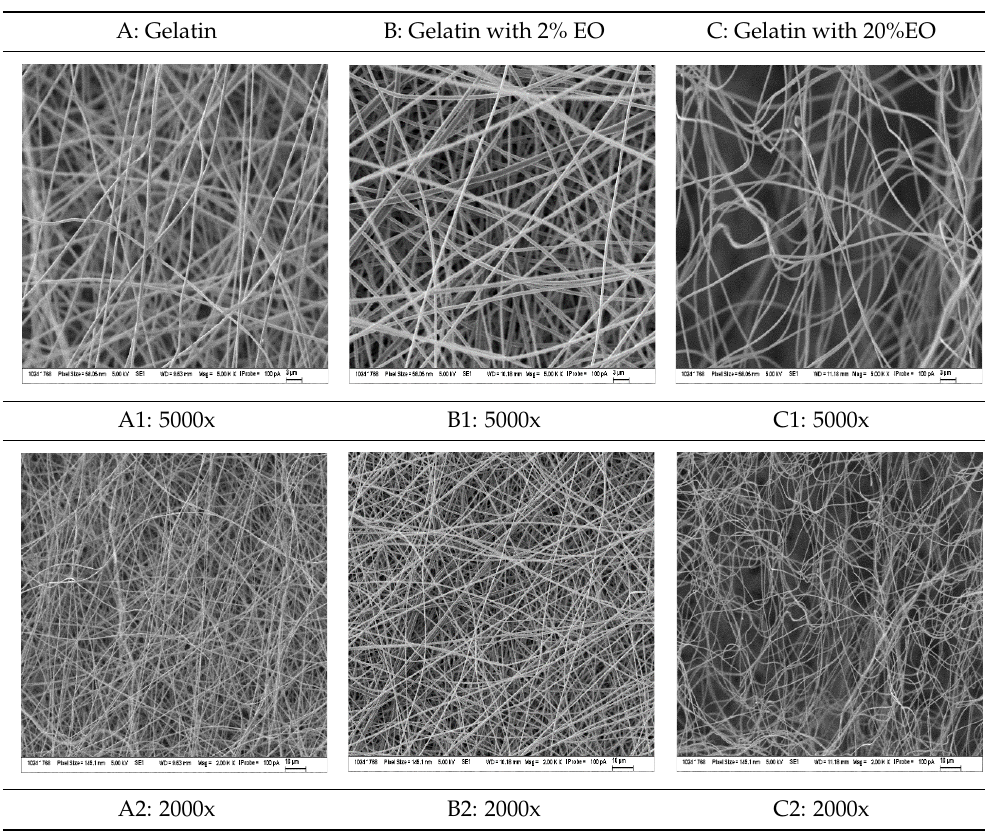
Table 9. Diameters of prepared fibers by electrospinning.